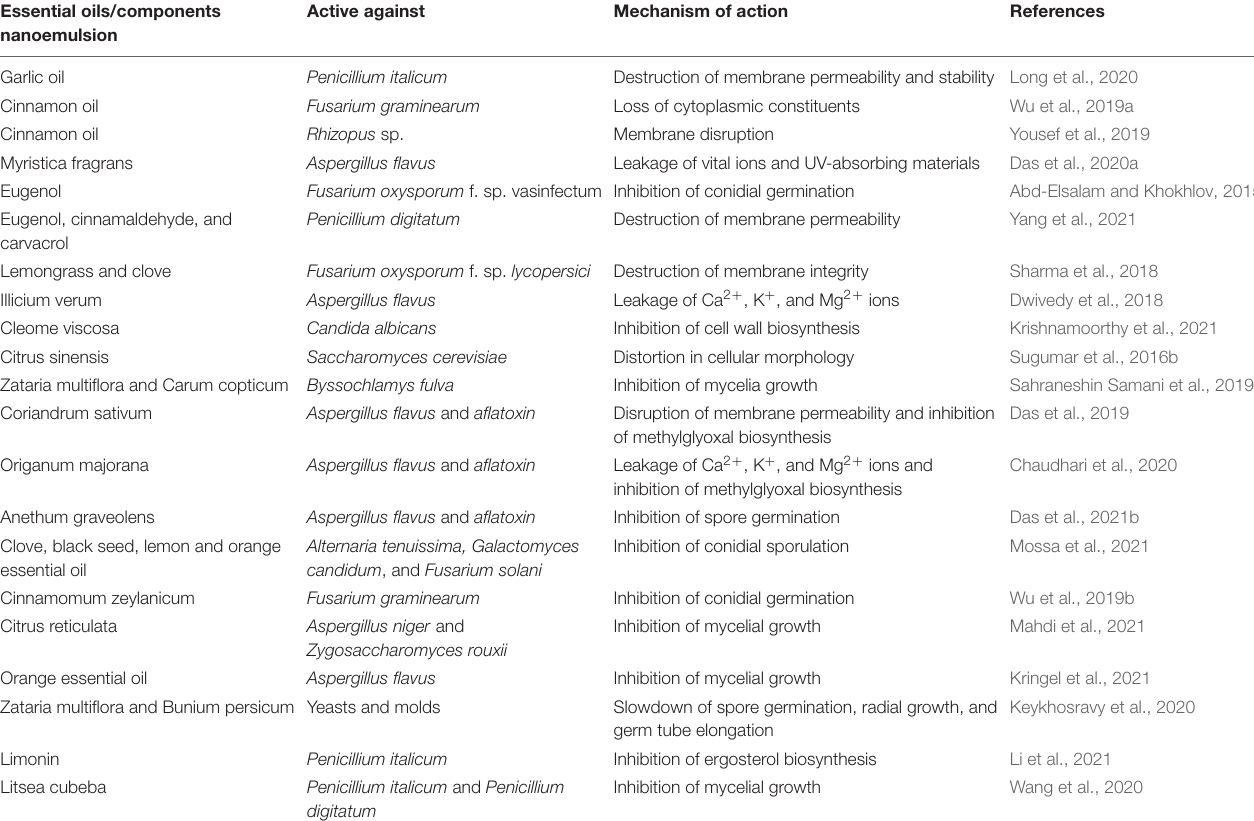
TABLE 2 | Antifungal and antimycotoxigenic mechanisms of action of essential oil/components-loaded